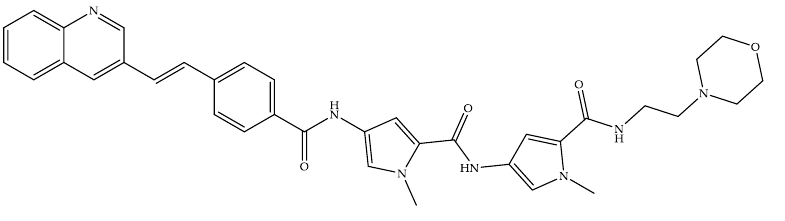
Figure 8. Chemical structure of MGB-BP-3.